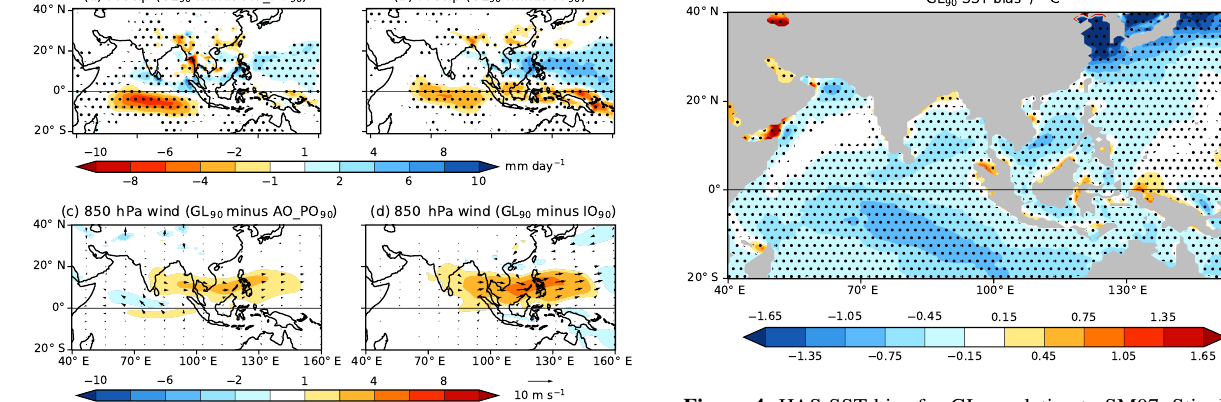
Figure 4. JJAS SST bias for GL 90 relative to SM07. Stippling in- dicates 99% statistical significance according to a two-tailed t test. Land and coastally tiled points (i.e. non-zero land fraction) are in grey.